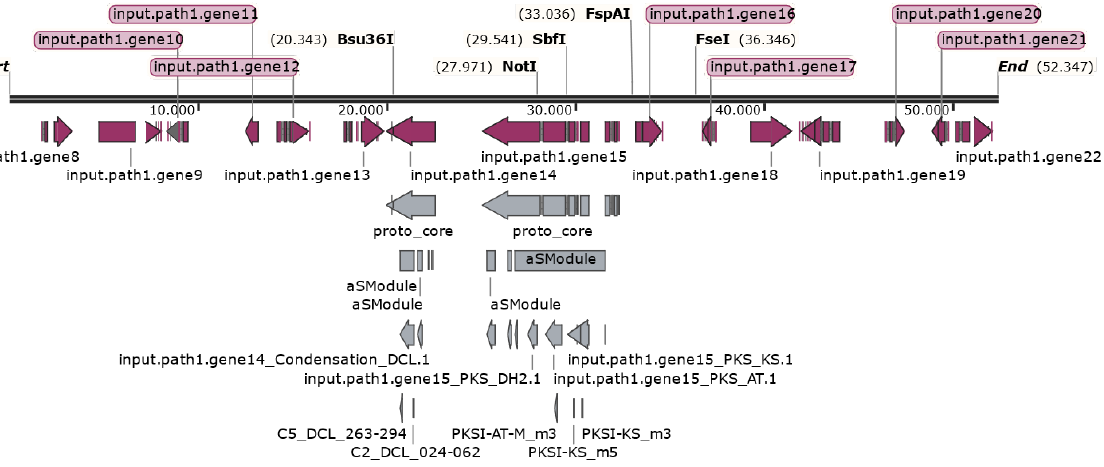
Figure 4. Biosynthetic genes of A. alternata and other genes whose function is unknown. The elucidation of genes of interest in phytopathogenic fungi through in silico or in vitro studies, such as genes encoding mycotoxins, as in the case of A. atra (a saprophytic fungus producing leaf blight on the potato) and A. arborescens (producing stem blight) that affects tomato crops and is a producer of host-specific toxins, is of great interest to combat losses associated with diseases transmitted by phytopathogenic fungi since they offer the possibility of applying the gene-editing techniques such as CRISPR/Cas9 or RNAi [67,68]. In this context, Wenderoth et al. (2019) reported the genes encoding AOH and its derivative AME in A. alternata by CRISPR/Cas9-mediated gene knockout [69]. In addition, information on genes associated with synthesizing secondary metabolites was reported. The associated genes consist of a group of 15 kb, including a pksI (polyketide synthase gene), omtI (an O-methyltransferase), and moxI (a FAD-dependent monooxygenase), sdrI (short-chain dehydrogenase), doxI (extradiol dioxygenase response gene), aohR (transcrip- tion factor gene). The inhibition of the transcription factor gene aohR generated a signifi- cant reduction in AOH levels, consequently decreasing the virulence in citrus, apple, and tomato crops [69].